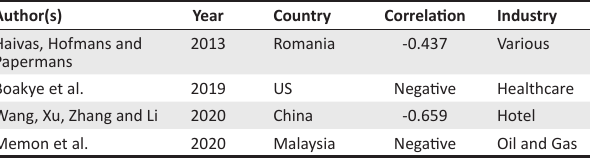
TABLE 3: Relationship between engagement and turnover intention.